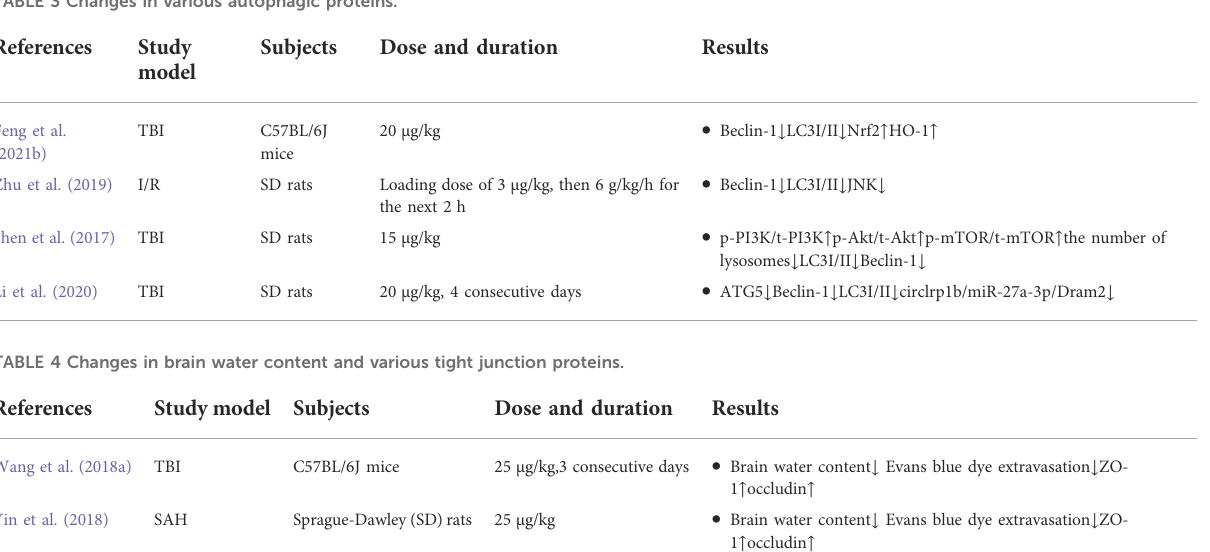
TABLE 3 Changes in various autophagic proteins.